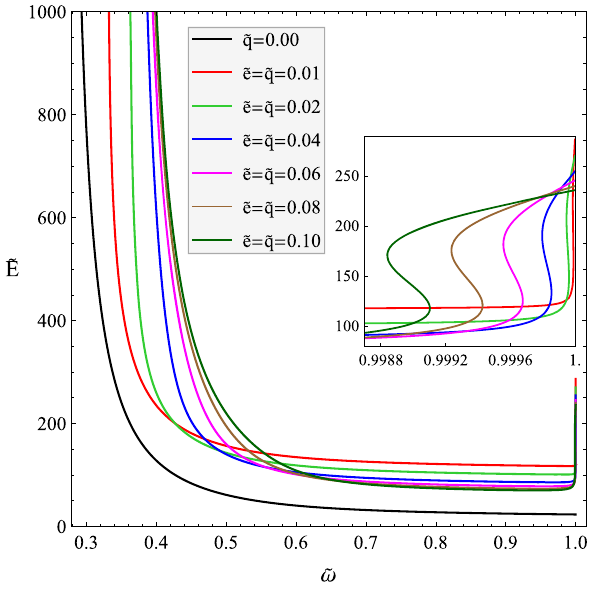
Fig. 1 Dependence of the energy ˜ E of the vortex-Q-ball system on the phase frequency ˜ ω for different values of gauge coupling constants. The curves correspond to parameters ˜ m = 1, ˜ g = 1, ˜ h = 0 . 2, ˜ λ = 0 . 125, ˜ v = 2, N = 1, and K = 0